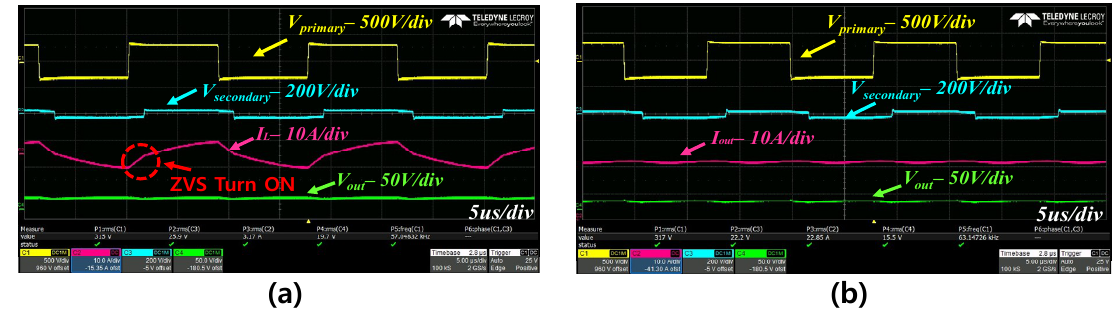
Figure 14. Super Capacitor CC mode charging waveform; ( a ) Vprimary, Vsecondary, IL, Vout; ( b ) Vprimary, Vsecondary, Iout, Vout.